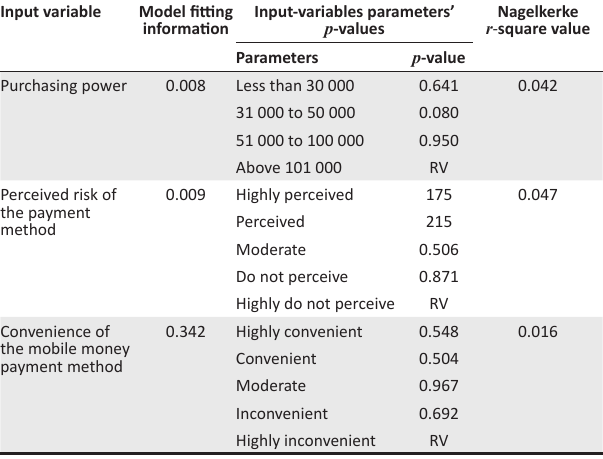
TABLE 3: Factors with insignificant influence on the perceived relevance of social-media-based commerce. Input variable